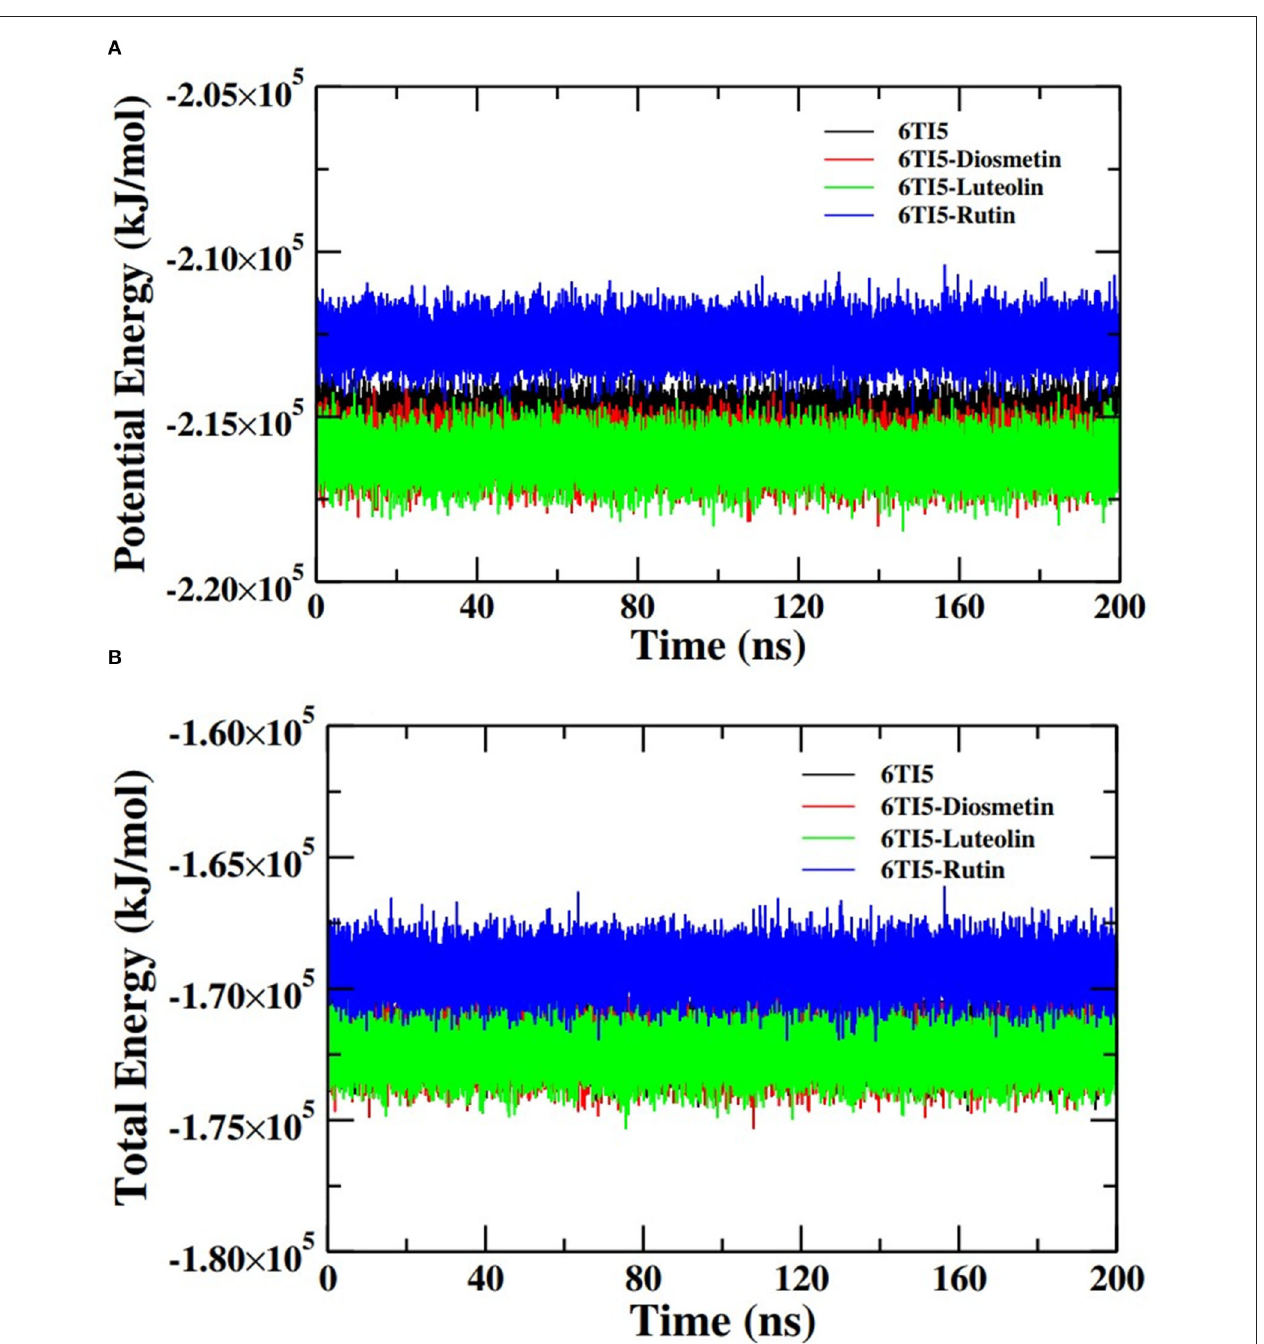
FIGURE 7 | (A) Potential energy (PE) and (B) total energy (TE) of the systems of 6TI5 and its complexes with Diosmetin, Luteolin and Rutin as a function of time.